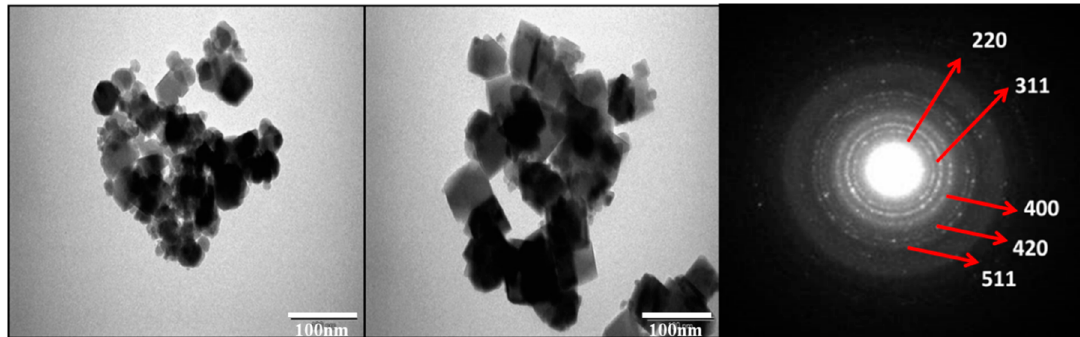
Figure 5. Transmission electron diffraction (TEM) images (with different magnetization) and selected area electron diffraction (SAED) pattern of Co 0.5 Ni 0.5 Nb x Fe 2 − x O 4 for x = 0.06 nanoparticles.